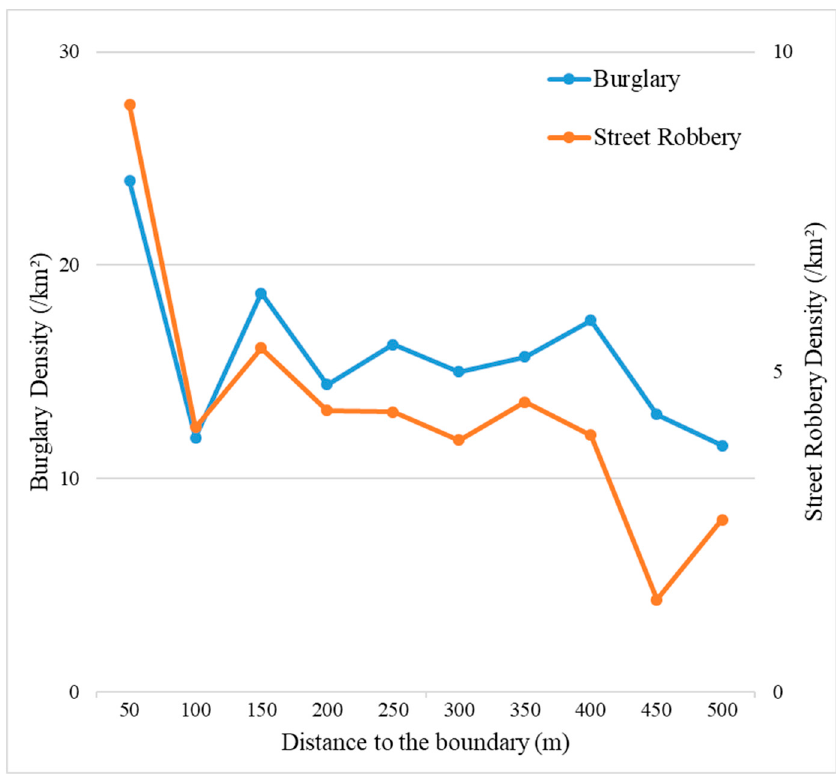
Figure 4. Patterns of street robbery and burglary on boundaries of tracts.